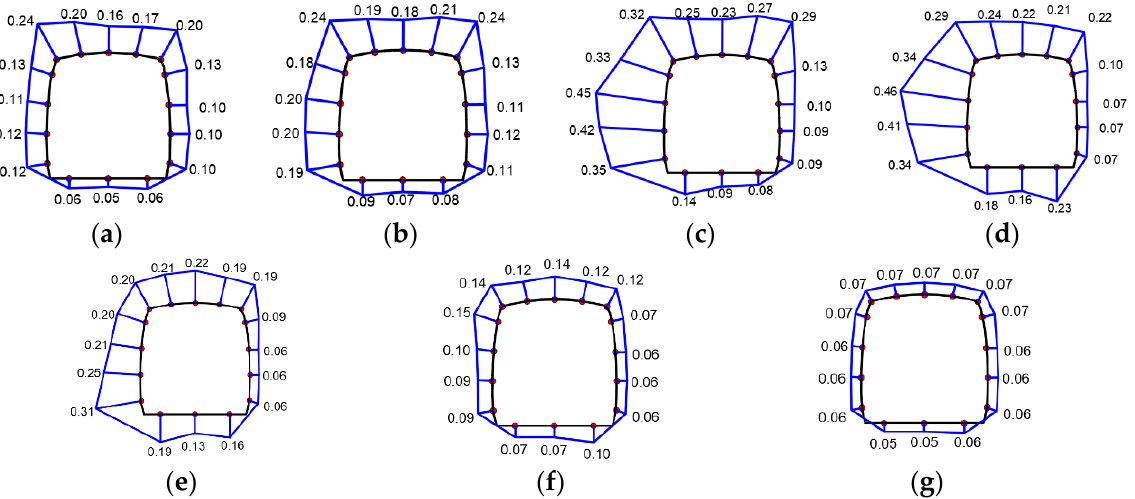
Figure 12. Fluctuations in pressure coefficients at the middle section with distance from the tornado’s center to train car ( S = 0.35, λ = 0). ( a ) R / R c = 0; ( b ) R/R c = 0.5; ( c ) R / R c = 1; ( d ) R / R c = 1.5; ( e ) R / R c = 2; ( f ) R / R c = 2.5; ( g ) R / R c = 3.75.